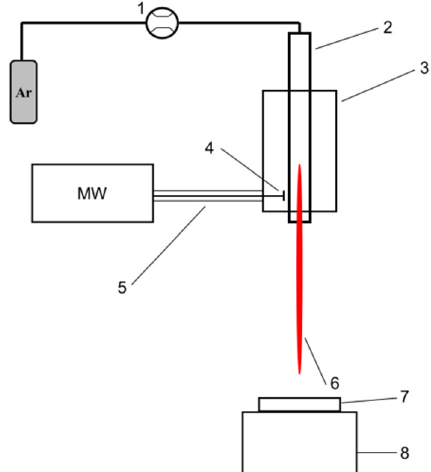
Figure 1. Scheme of the experimental set up: 1—mass flow controller; 2—quartz capillary; 3—surfatron resonator; 4—MW antenna; 5—MW-coaxial cable; 6—plasma beam; 7—Petri dish with inoculated Candida glabrata culture; 8—Petri dish holder.